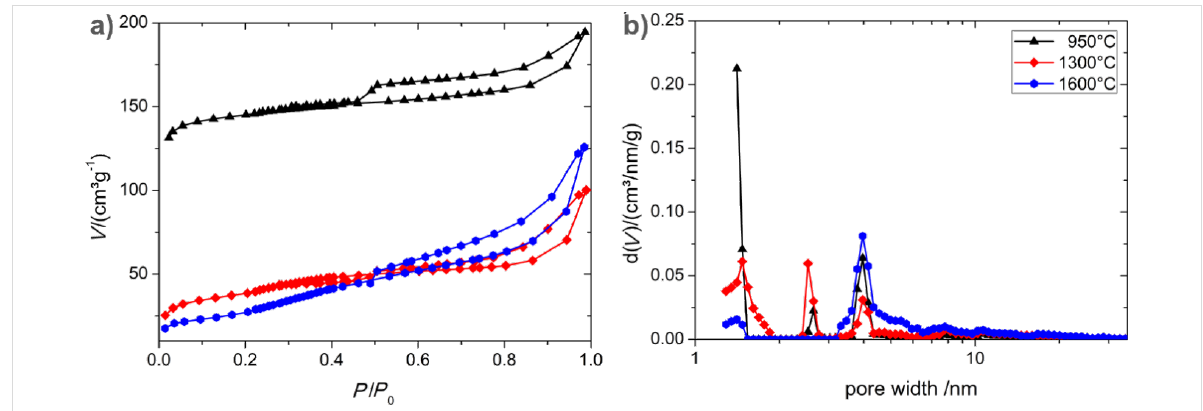
Figure 6: (a) Nitrogen adsorption–desorption isotherms at 77 K and (b) pore size distribution function from adsorption (DFT, slit pore model) for car- bon tubes ( 4 ) which are carbonized at 950 °C (black/triangles), 1300 °C (red/diamonds) and 1600 °C (blue/circles).